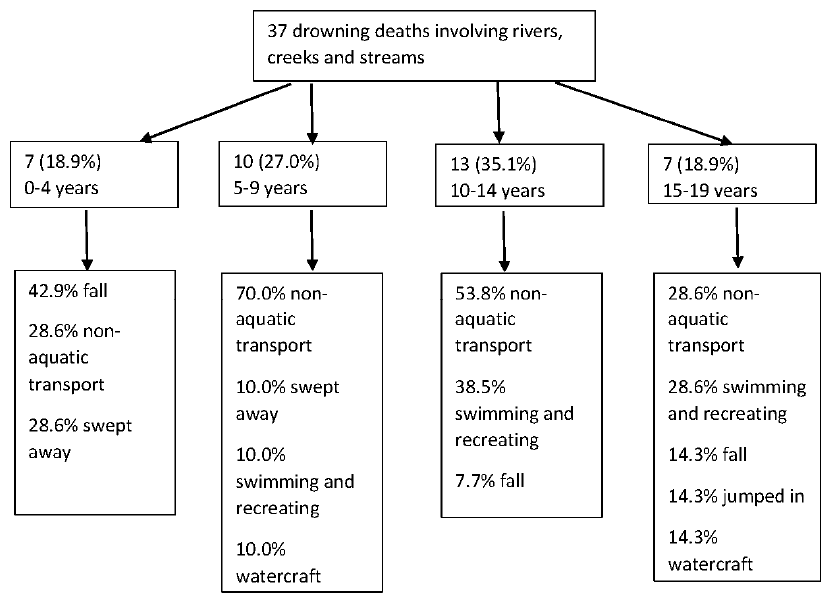
Figure 2. Flow chart exploring river flood related child and adolescent drowning deaths, activities presented in rank order, 0–19 years by age group, Australia, 2002 / 03–2017 / 18 (n = 37). Table 2. Demographics and circumstances of child and adolescent unintentional flood-related drowning deaths, by age group of drowning victim, Australia, 2002 / 03–2017 / 18 (N =